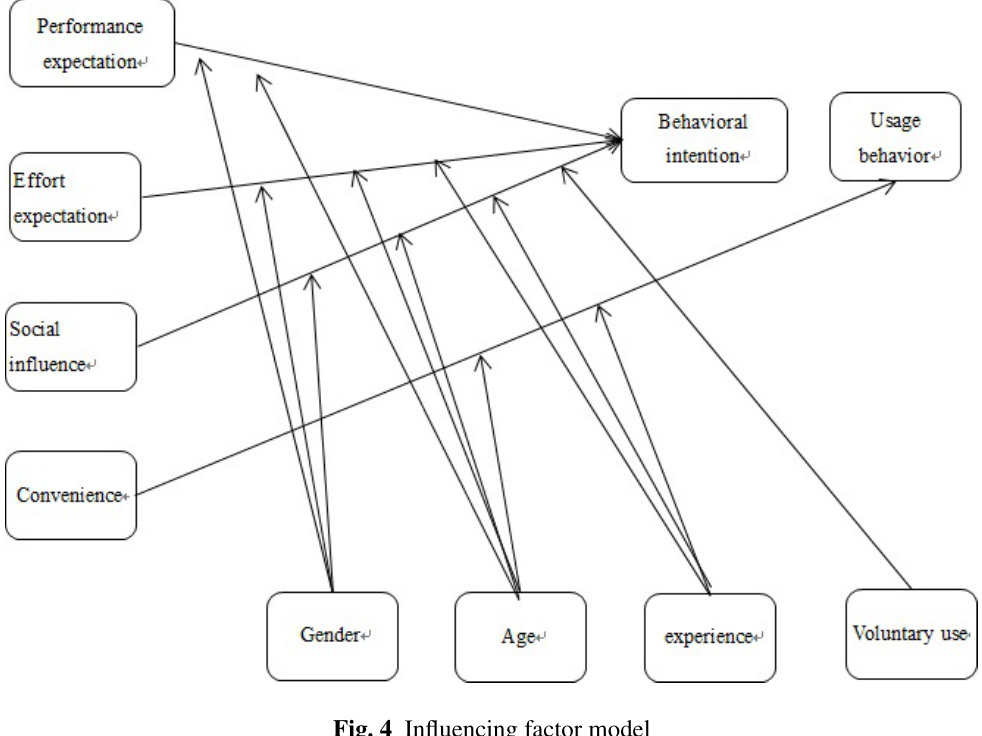
Fig. 4 Influencing factor